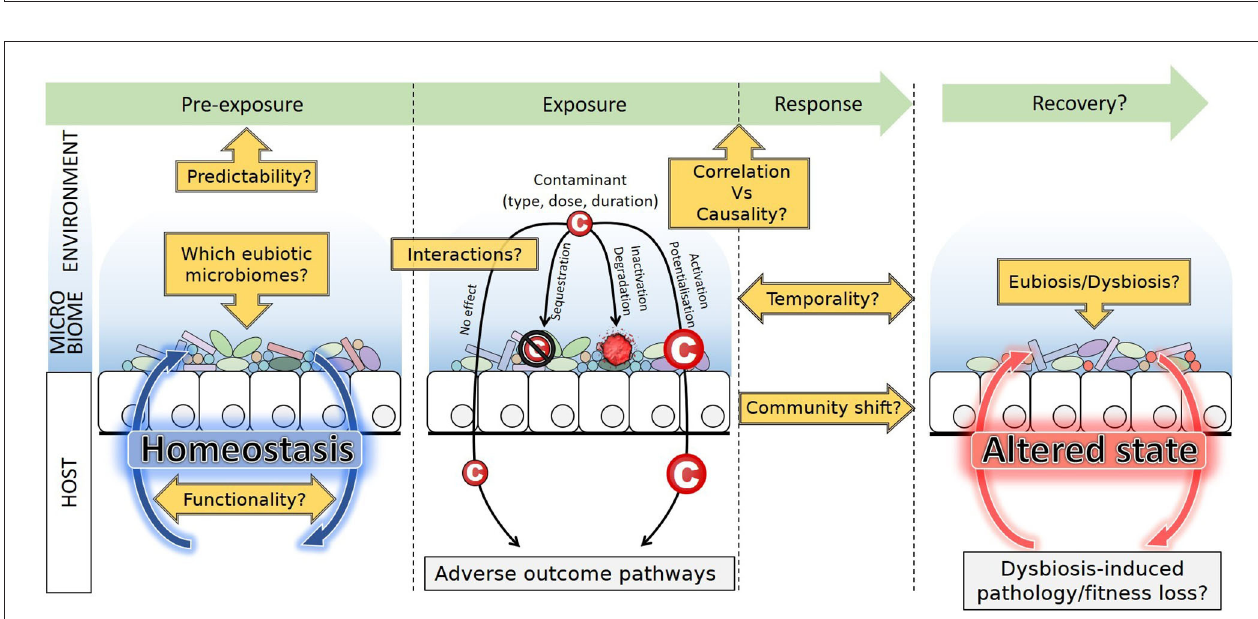
FIGURE 1 | Ecotoxicology studies the effect of chemicals on organisms at the population level. A microbiome-aware ecotoxicology perspective acknowledges the importance of associated microorganisms in their hosts biology, at the level of individuals as well as populations. Indeed, the microbiome is interacting with hosts, environment, and contaminants and may be linked with health status (here, light vs. dark gray). The microbiome thus needs to be integrated as an element of the system, and protocols to investigate ecotoxicological effects at each level need to be adapted.